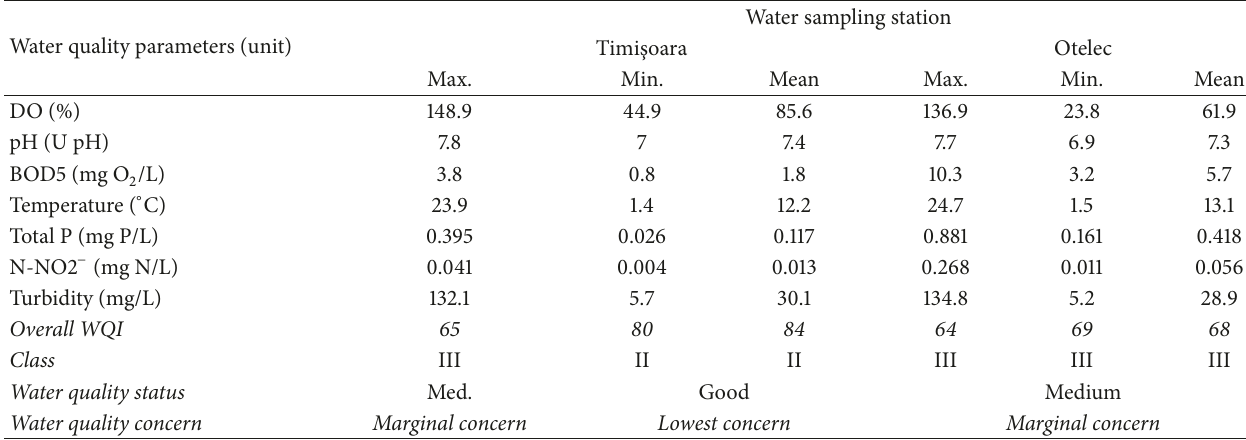
Table 5: Water quality status and WQI values at sampling stations from the Bega